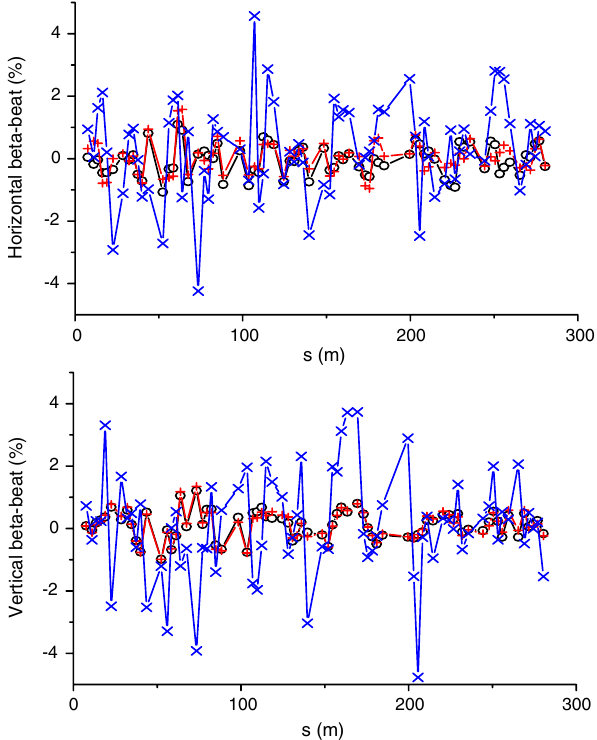
FIG. 4. Reconstructed beta-beat with LOCO and the fitting algorithm from Ref. [4]. Black circles are from LOCO, red crosses from the algorithm of Ref. [4] with BPM gain correction and blue crosses without